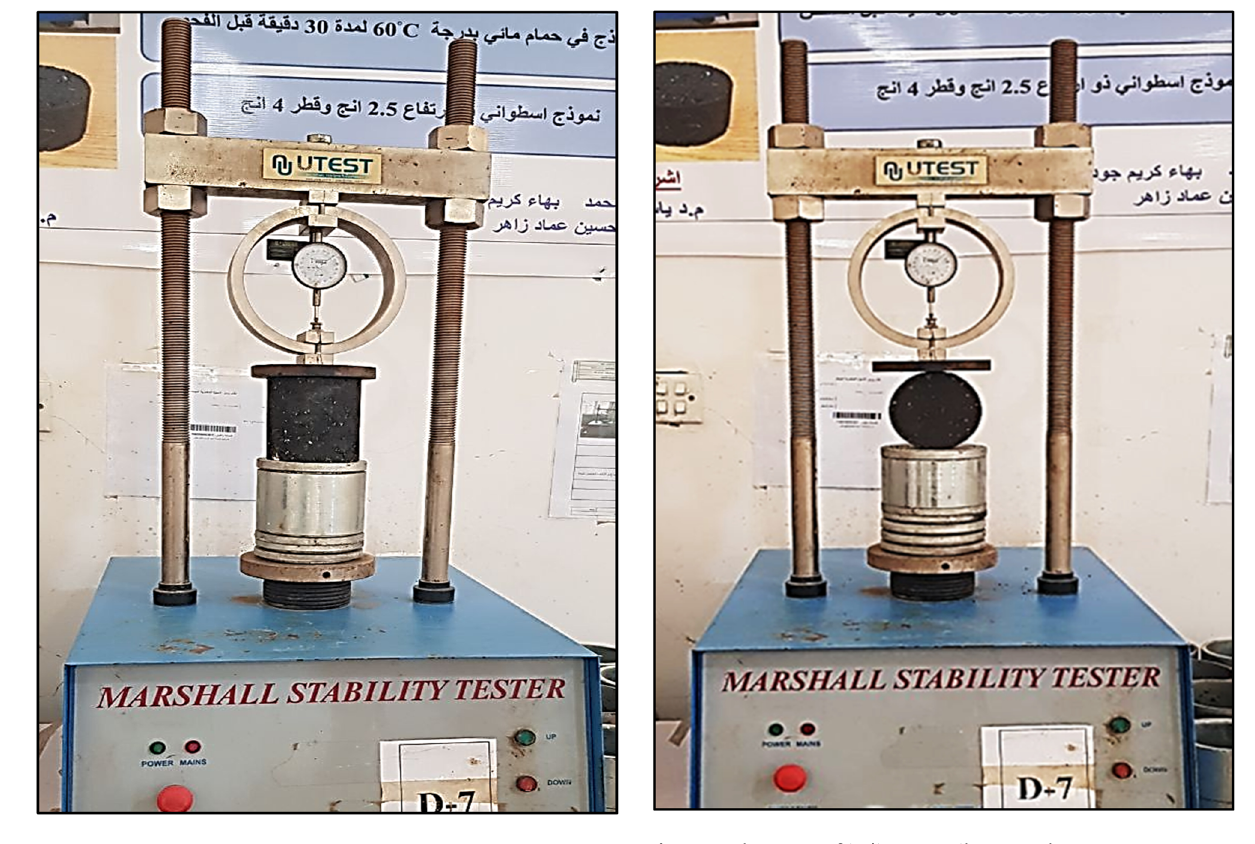
Figure 2: The setup of compression apparatus. Figure 3: The setup of indirect tensile strength